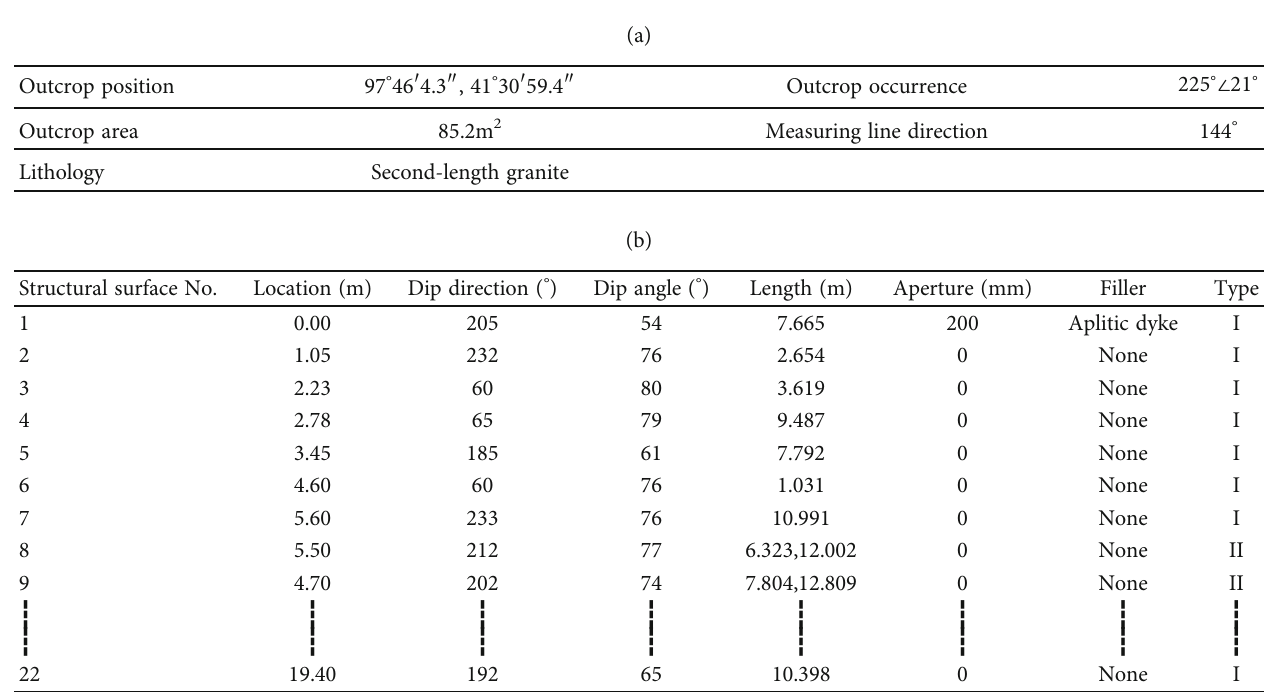
Figure 3: Comprehensive joint investigation. Table 2: Record chart of joint geometry